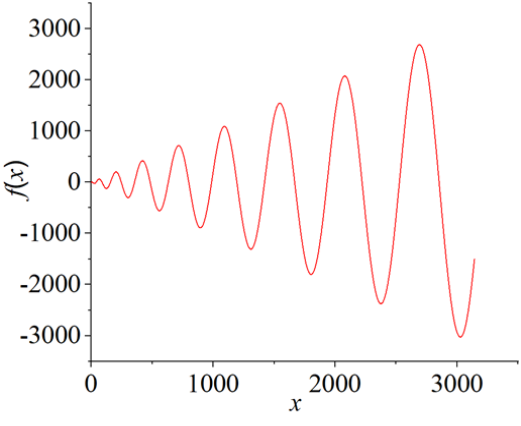
Figure 6. Standard Schwefel function.